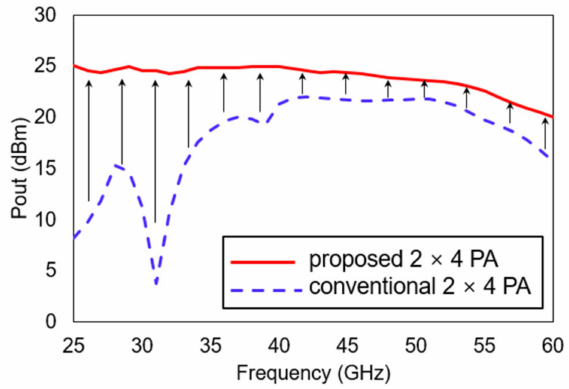
Figure 6. Output power comparison of the designed PAs according to frequency (input power = 15 dBm).